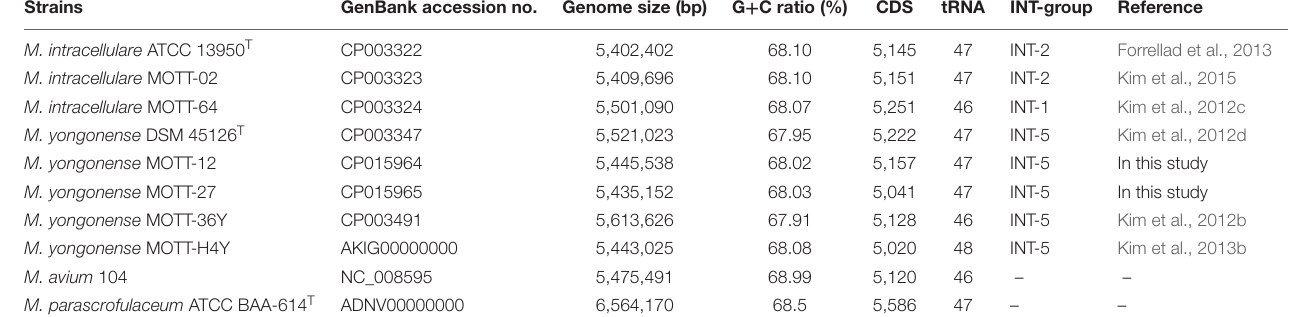
TABLE 1 | Genome sequences used in this study. Strains